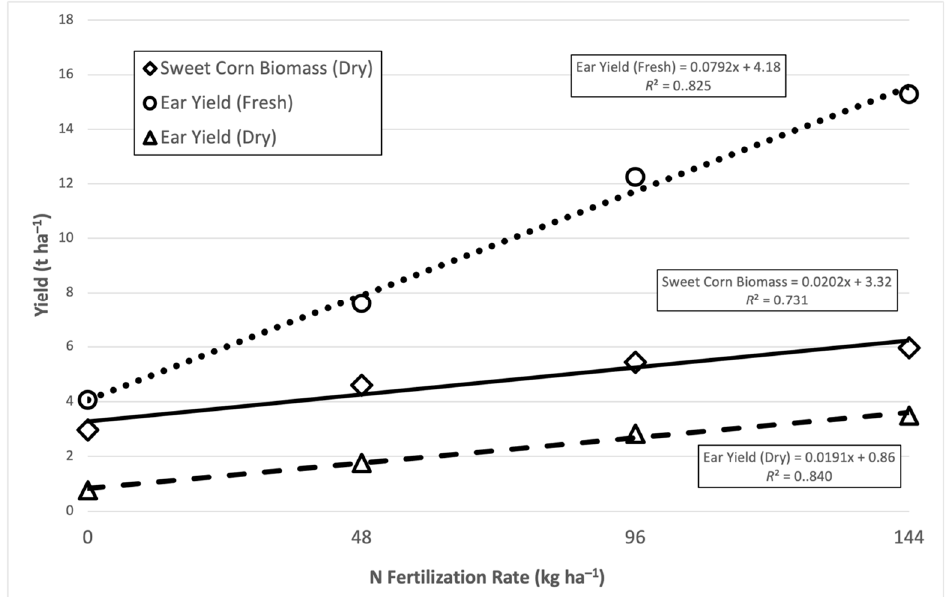
Figure 8. Mean dry sweet corn biomass and ear yield by weight as a function of N fertilization rate in 2021. Goodness of fit described with conditional R 2 .